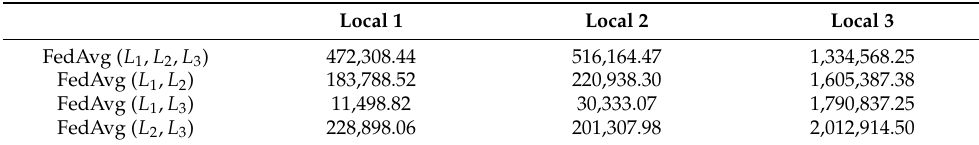
Table 3. Average MAE result for local combinations. Local 1 Local 2 Local 3 FedAvg ( 𝐿 (cid:2869) ,𝐿 (cid:2870) ,𝐿 (cid:2871) )